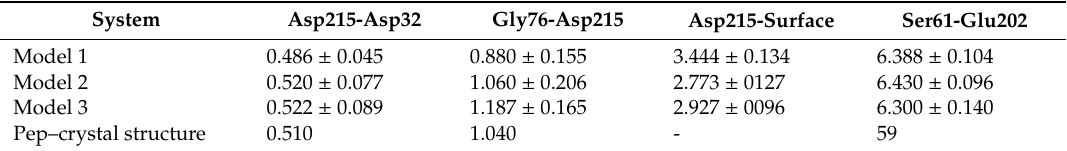
Table 2. Calculated average inter-atomic distances (nm) between pepsin residues with standard deviations. Distances from the 4PEP crystal structure (nm) are reported for